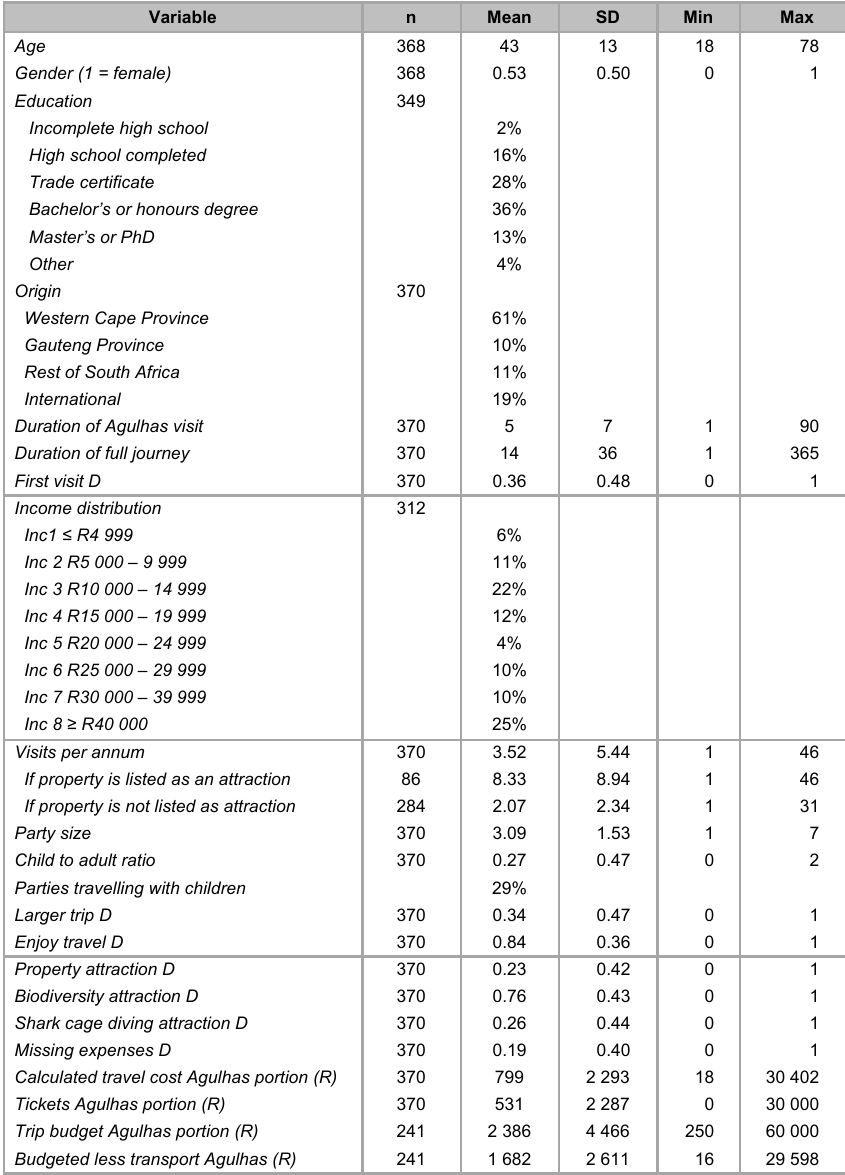
Summary statistics of a sample of Agulhas Plain visits in